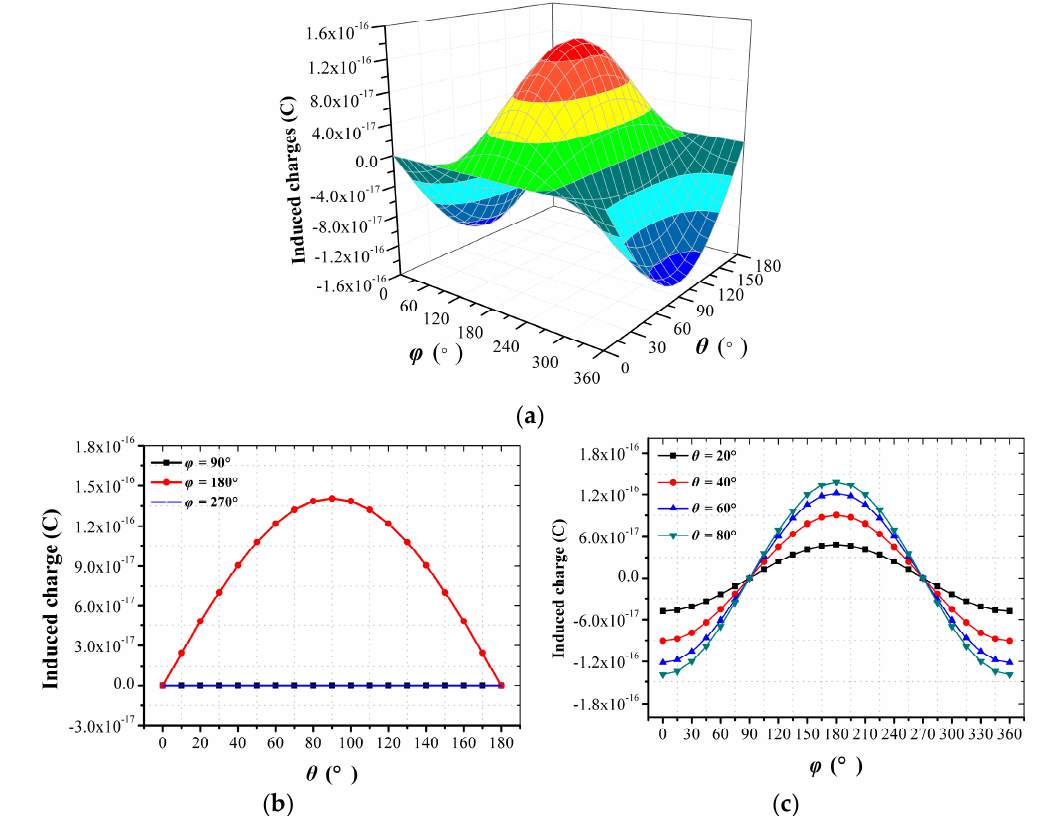
Figure 3. Simulation results of the proposed 1D EFSC’s response to the electric field with different directions. ( a ) Q x with respect to θ and φ ; ( b ) Q x with respect to θ when φ is 90°, 180°, and 270°; ( c ) Q x with respect to φ when θ is 20°, 40°, 60°, and 80°.